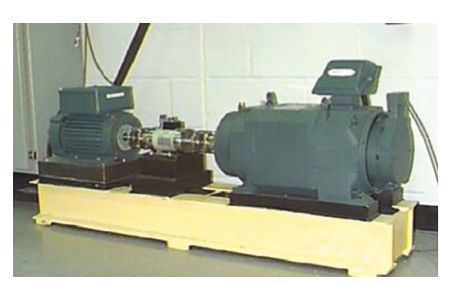
Figure 11: Bearing experimental